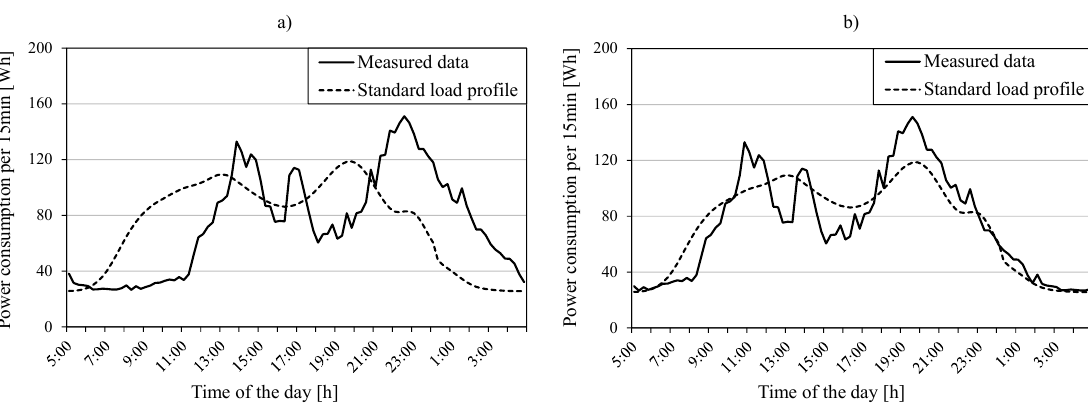
Figure 4. Comparison of the inhabitants’ energy consumption profile with the German standard load profile for comparable household size and time of the year. ( a ) No time shift, ( b ) time shift of − 3 h.